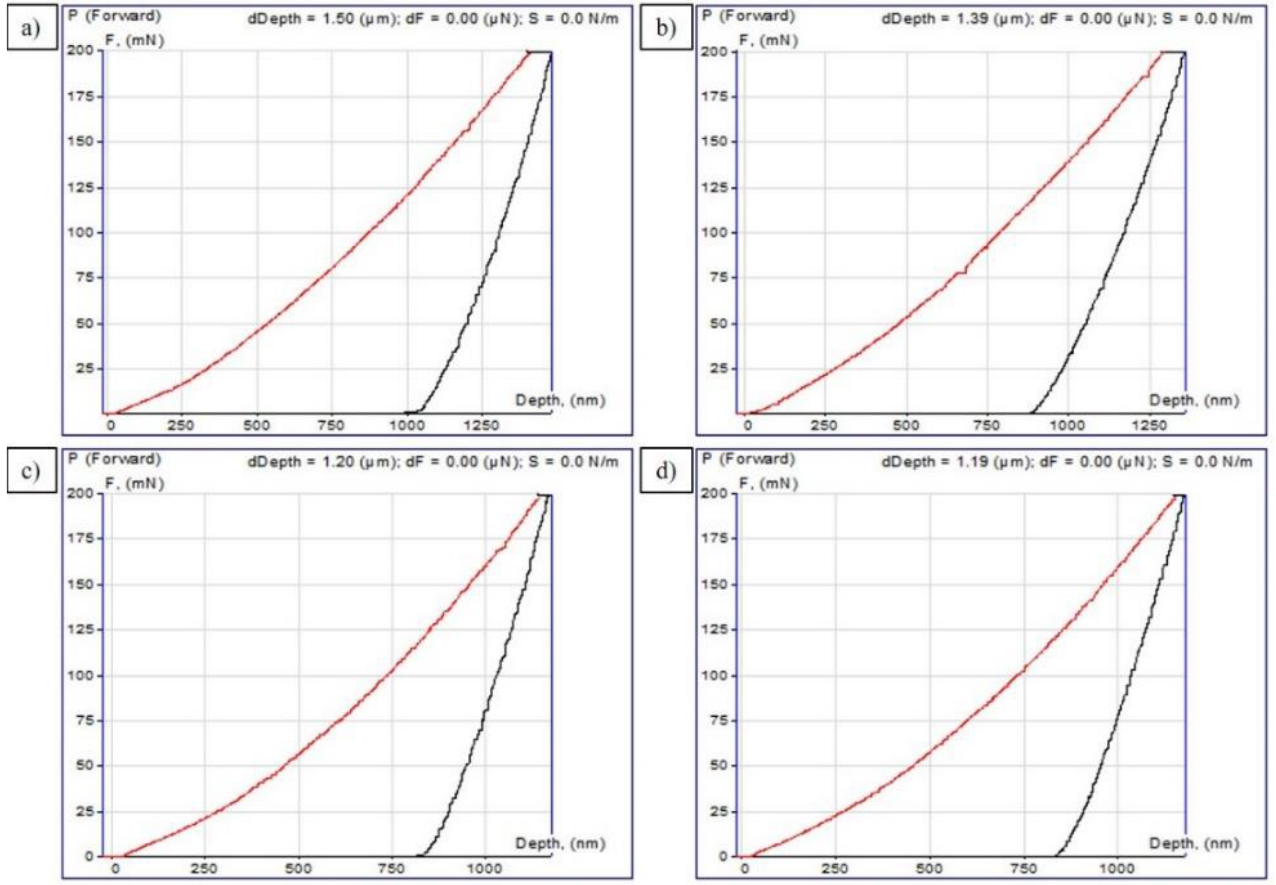
Figure 6. P − h-diagrams curves of 30CrMnSiA steel after EPTCH: ( a ) No. 1; ( b ) No. 2; ( c ) No. 3; and ( d ) No. 4.